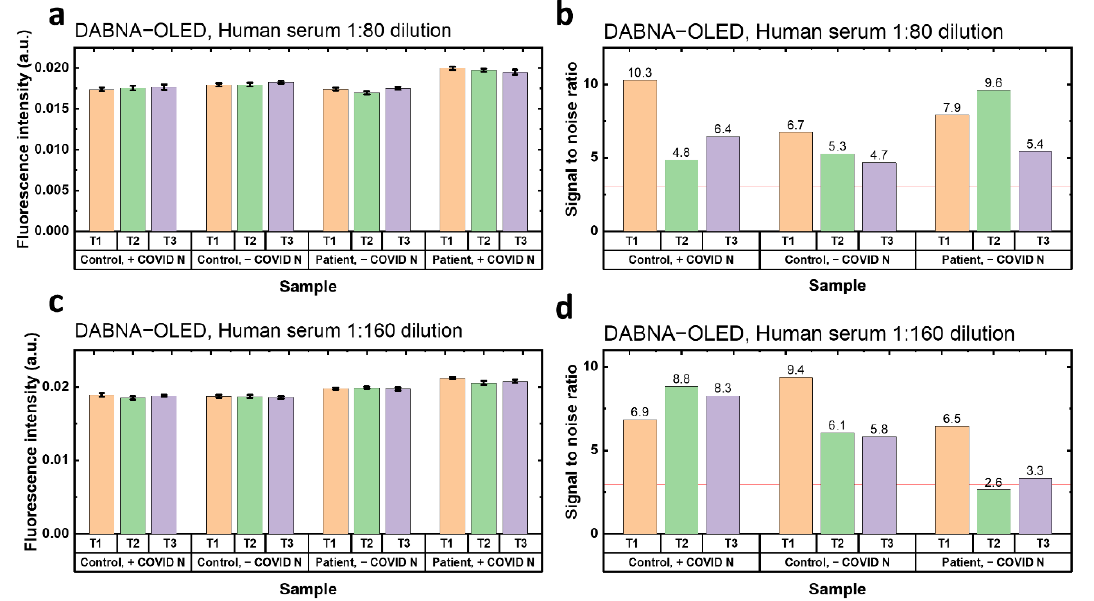
Figure 4. Results of OLED − FLISA (DABNA − OLED) for sensing antibodies to SARS-CoV-2. Each sample was measured three times. ( a ) Fluorescence intensity of samples tested with 1:80 dilution of human serum under the DABNA − OLED excitation. ( b ) SNR of samples tested with 1:80 dilution of human serum under the DABNA − OLED excitation. ( c ) Fluorescence intensity of samples tested with 1:160 dilution of human serum under the DABNA − OLED excitation. ( d ) SNR of samples tested with 1:160 dilution of human serum under the DABNA − OLED excitation. The error in the fluorescence intensity is shown in ( b , d ), but is hard to see because it is small compared to the overall fluorescence